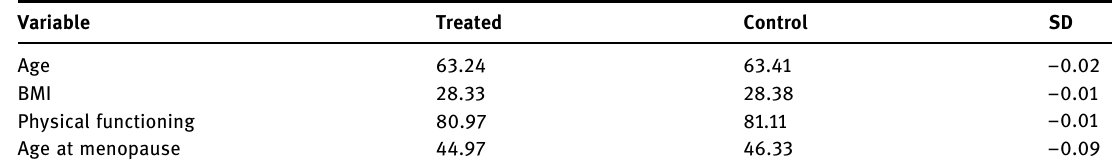
Table A4: Standardized di ff erences ( SD ) between treated and control populations in RCT gold dataset, for clinical risk factors for coronary heart disease Variable Treated